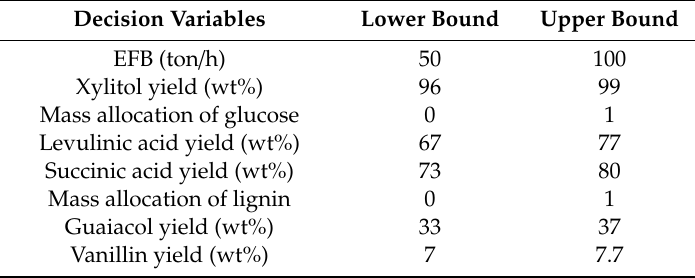
Table 4. The decision variables of the integrated